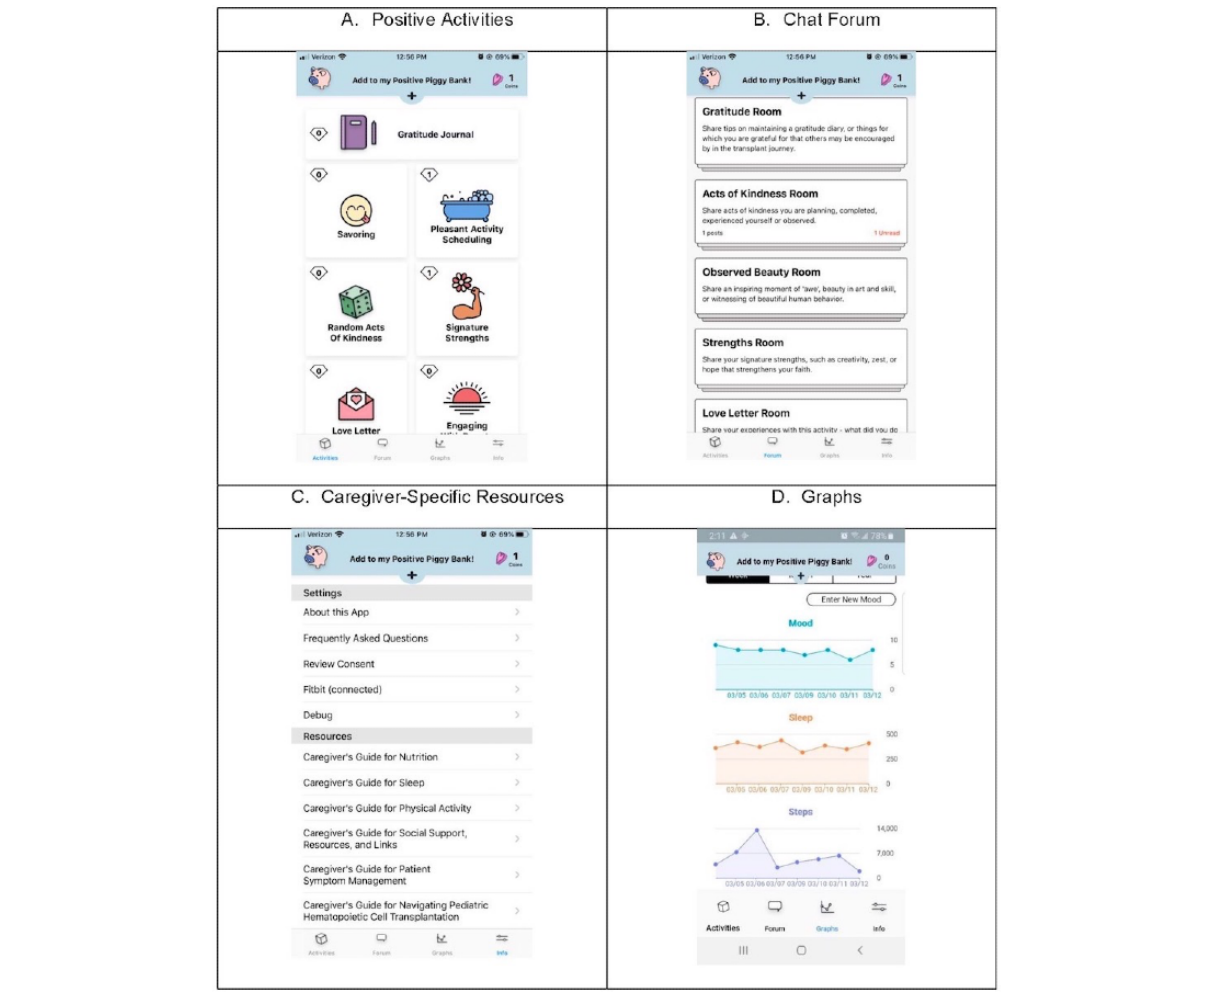
Figure 1. Screenshots of the Roadmap 2.0